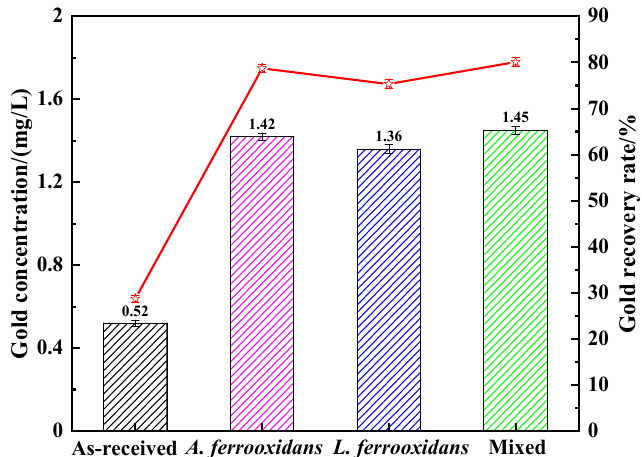
Figure 7. E ff ect of di ff erent treatments on gold recovery rates of Figure 7. Effect of different treatments on gold recovery rates of DRGO.